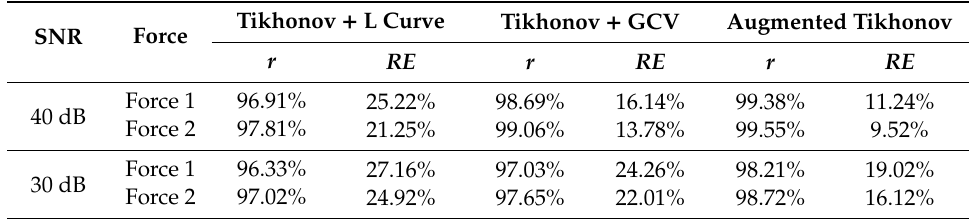
Table 2. Identification e ff ect of two sinusoidal loads.